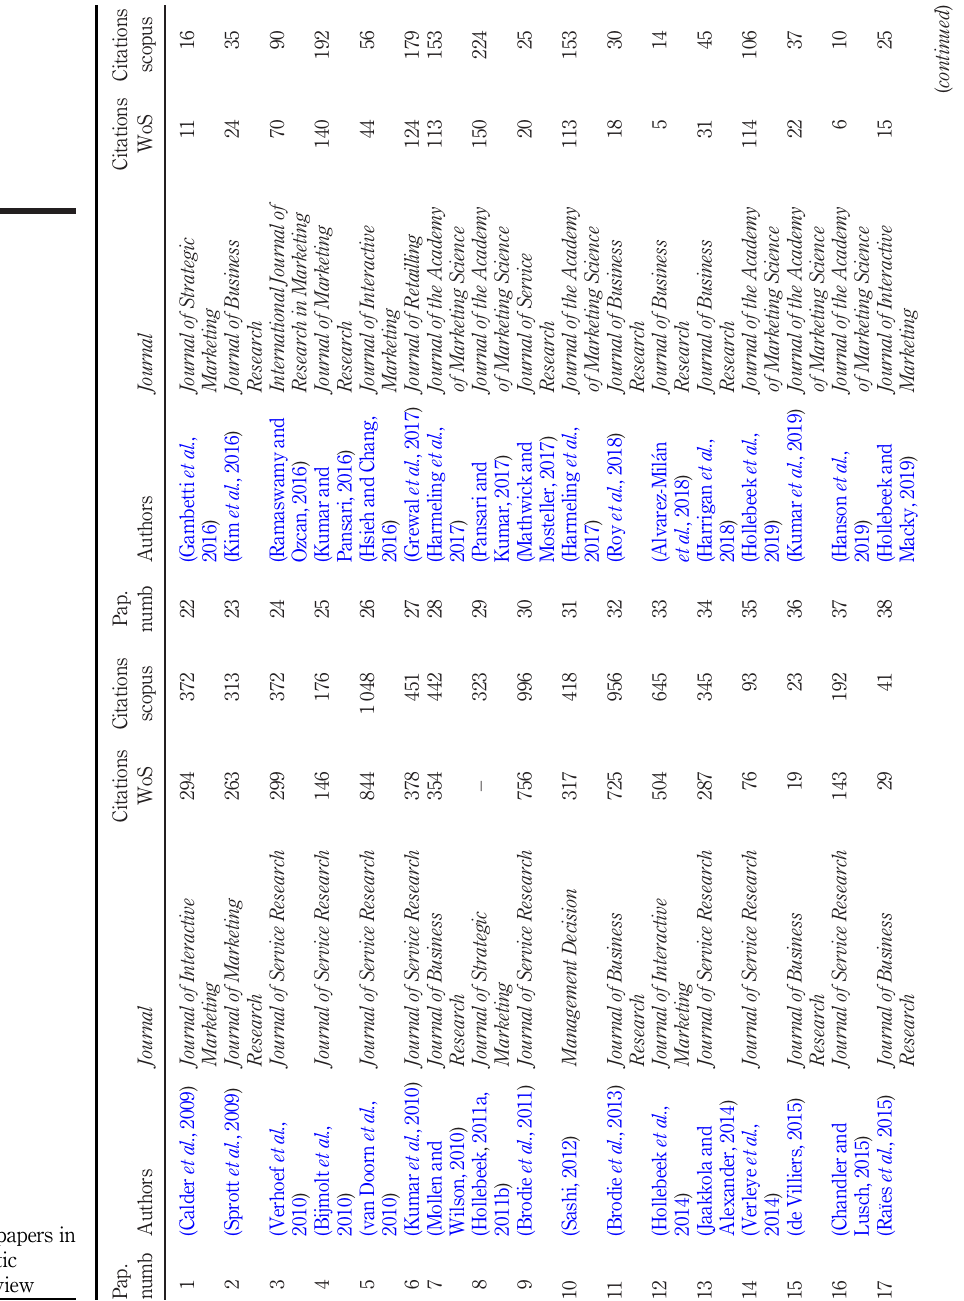
Table 2. Final list of papers in the systematic literature